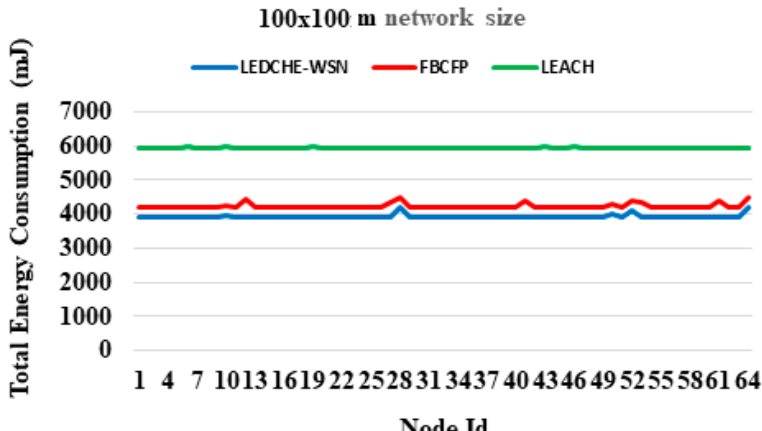
Figure 7. Total energy consumption for each node considering a 100 × 100 m network size for LEACH, FBCFP, and LEDCHE-WSN protocols .